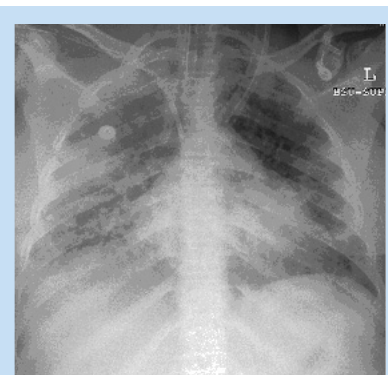
Fig.2.Bed side unit supine chest